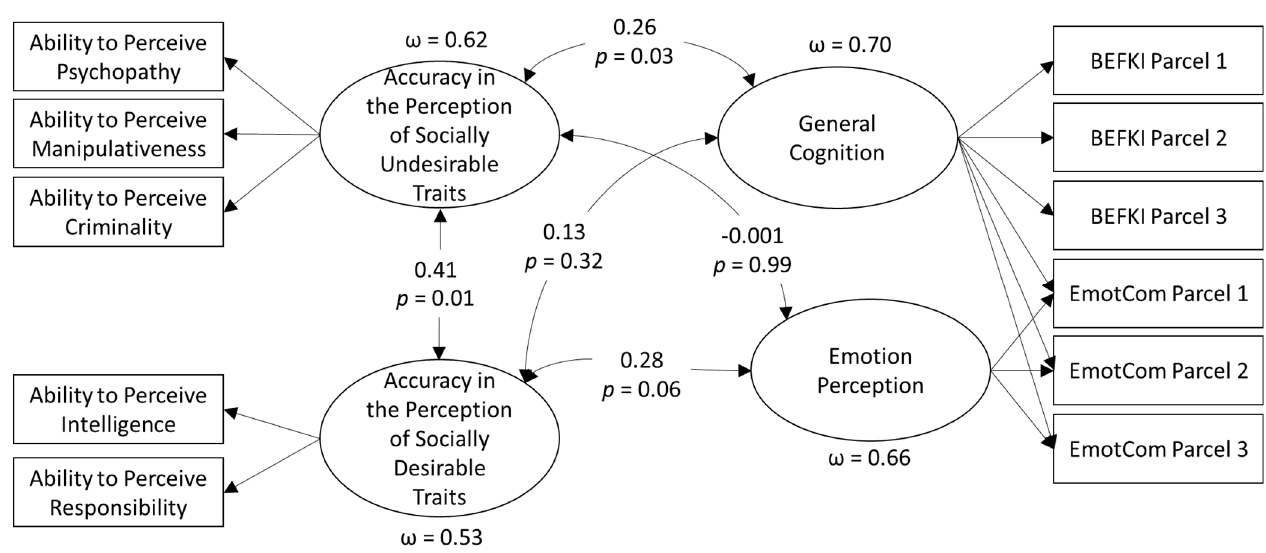
Figure 3. Structural Model Relating Person Perception accuracy with Cognitive Abilities